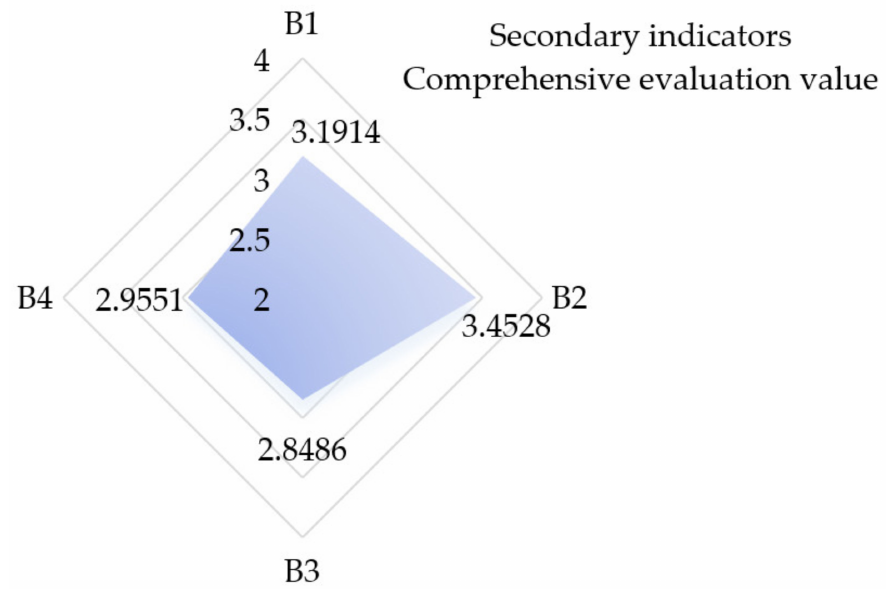
Figure 7. Results of comprehensive evaluation value of secondary